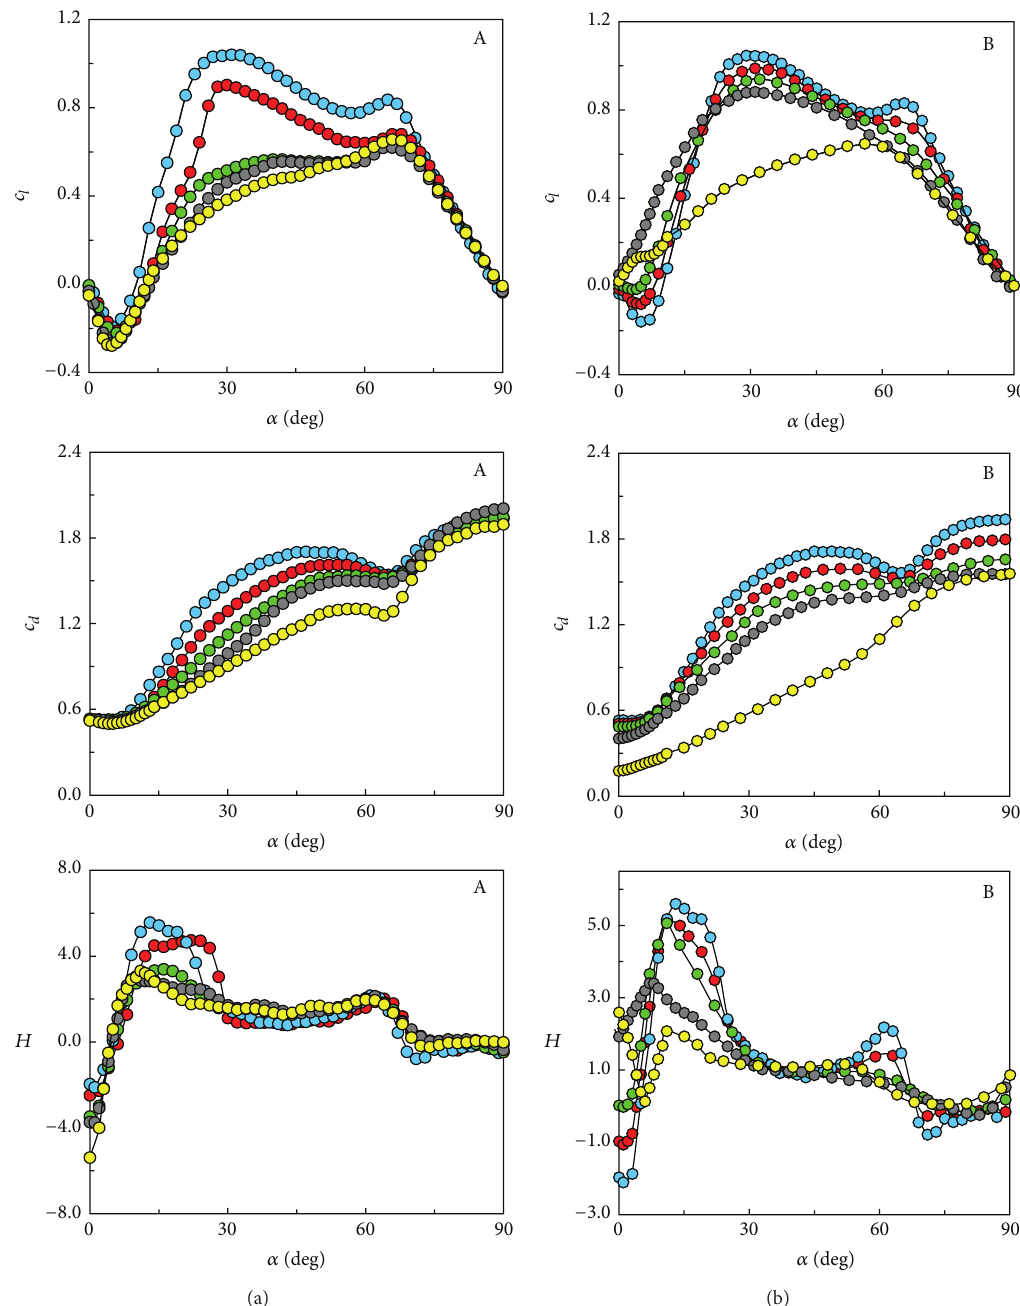
Figure 4: Variation with the angle of attack, 𝛼 , of the lift coefficient, 𝑐 𝑙 , the drag coefficient, 𝑐 𝑑 , and the Den Hartog parameter 𝐻 . Left column, type A beams, with different 2𝑎/𝑐 ratio (the symbols identify the values of the parameter 2𝑎/𝑐 according to the key: 2𝑎/𝑐 = 1 , yellow; 2𝑎/𝑐 = 0.8 , grey; 2𝑎/𝑐 = 0.6 , green; 2𝑎/𝑐 = 0.2 , red; 2𝑎/𝑐 = 0.03 , blue). Right column, type B beams, with vertical plates with different porosities (the symbols identify the values of the parameter 𝜙 according to the key: 𝜙 = 1 , yellow; 𝜙 = 0.6 , grey; 𝜙 = 0.4 , green; 𝜙 = 0.2 , red; 𝜙 = 0 ,